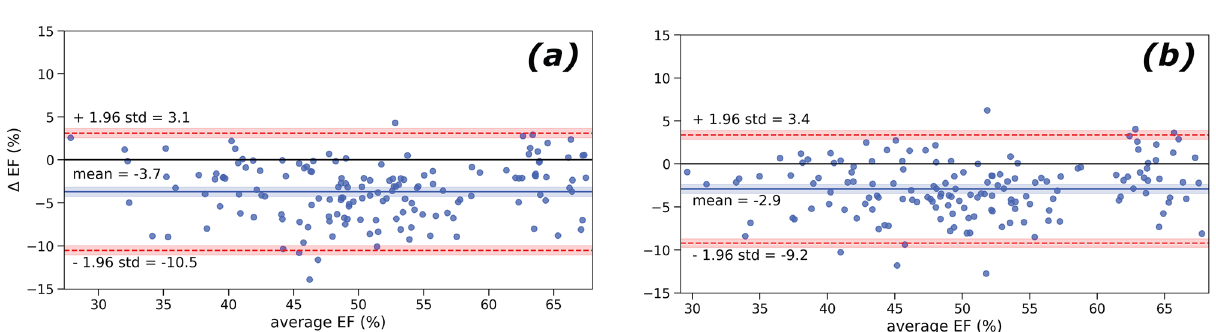
Figure 5. Bland–Altman plots for agreement analysis for pooled Study 5 and Study 6 using the 1MSA (bias = − 3.7 ± 3.5) ( a ) and 2MSA (bias = − 2.9 ± 3.2) ( b ). The bias is marked with a solid blue line ( ─ ) and its 95% CI shaded in blue. The equality line is marked with a solid black line ( ── ). The upper and lower 95% CI are marked with discontinuous red lines ( -- ) and are shaded with their respective 95% CI in red.